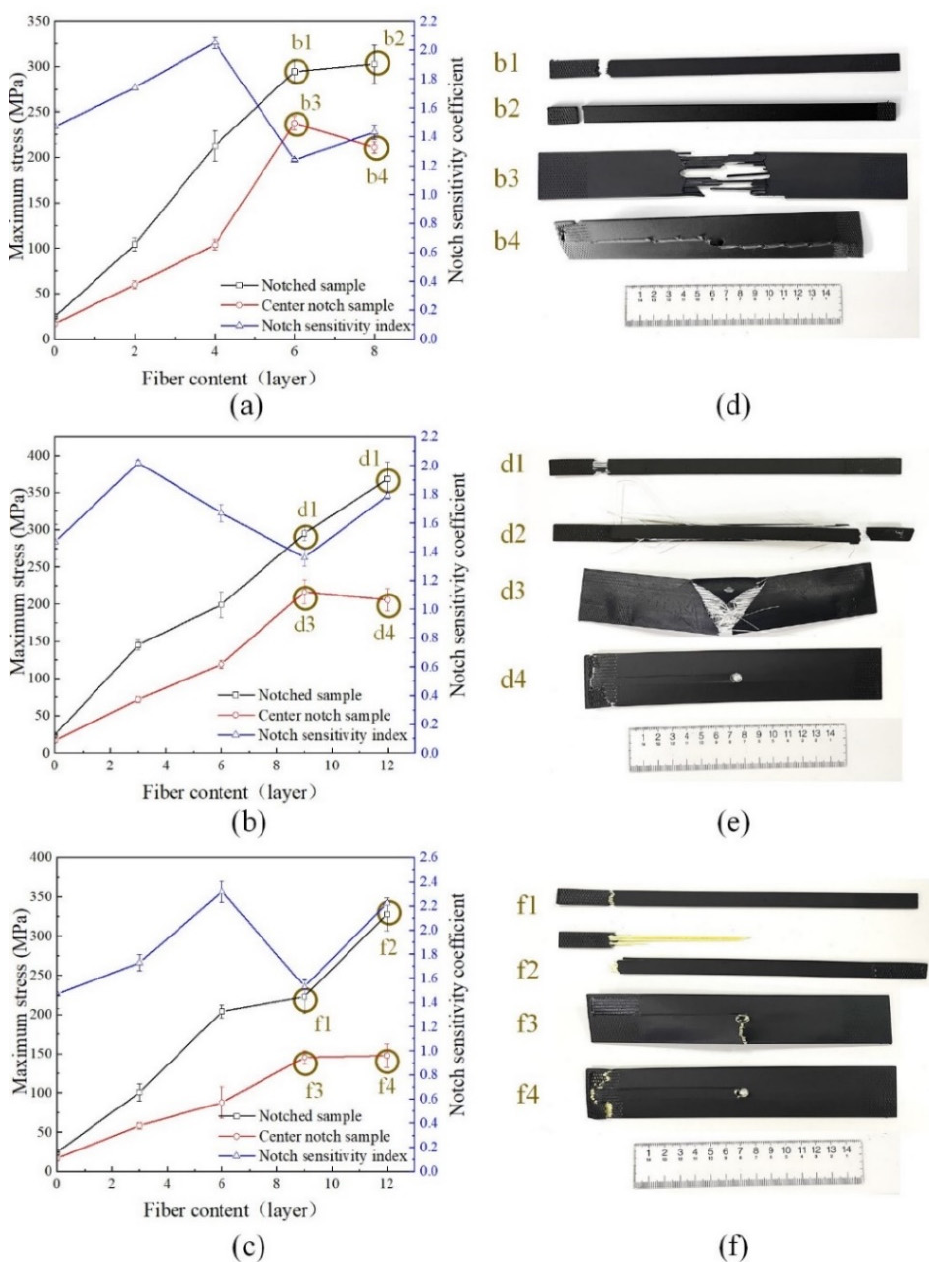
Figure 8. The tensile strength of composites containing ( a ) carbon fiber, ( b ) glass fiber, and ( c ) Kevlar fibers with the different contents, tensile failure diagram of un-notched specimen, and central notch specimen with ( d ) carbon fiber, ( e ) glass fiber, and ( f ) Kevlar fibers.